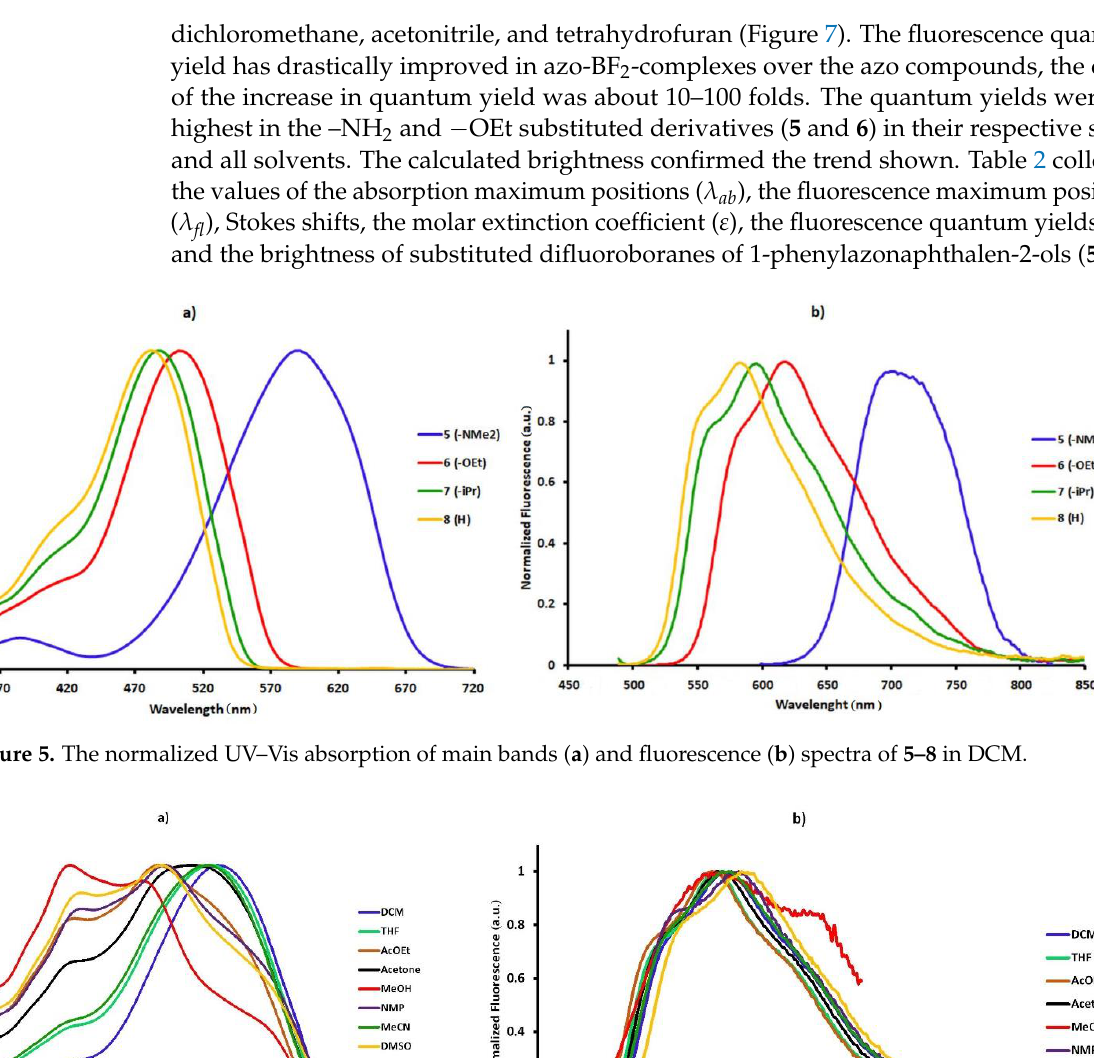
Materials 2021 , 14 , x FOR PEER REVIEW 10 of 20 ure 5a). In this case, the maximum of absorbance shifted towards higher wavelength val- ues as the polarity of solvent increased (Figure 6a). The fluorescence emission of 5 – 8 ex-